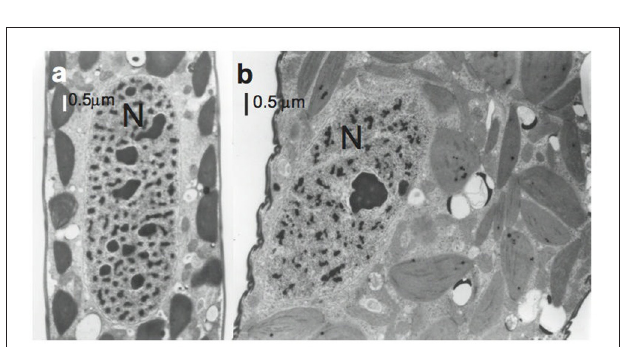
FIGURE 5 | Electron micrographs of Lepocinclis acus nuclei. (a) Control cell where the nucleus (N) is centrally located. (b) Treated cell where the nucleus is laterally